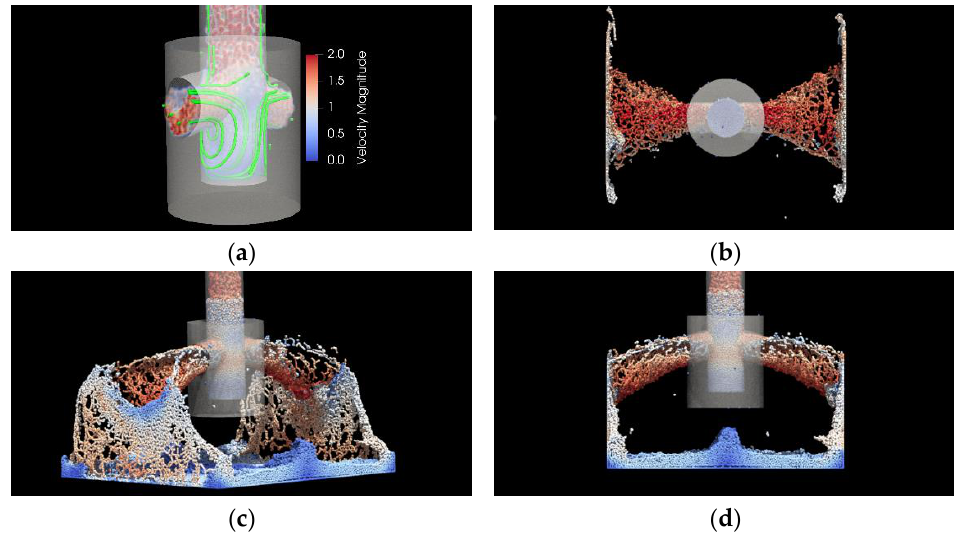
Figure 12. WB-20 SEN model with a pool and without a flow separator. Description of each panel in the figure is the same as in Figure 10.